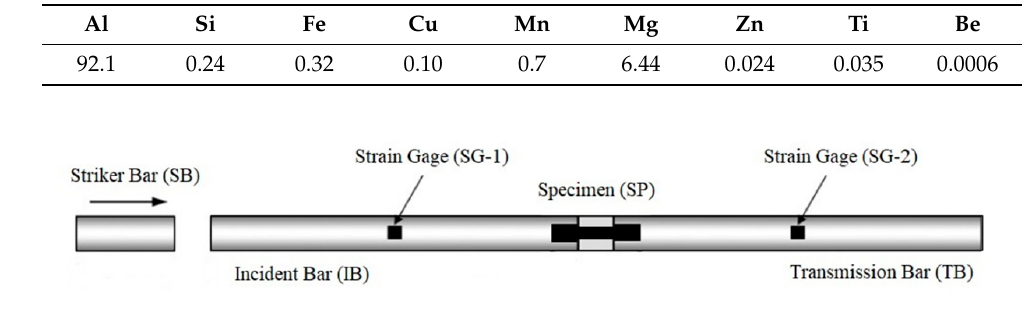
Figure 1. Split Hopkinson pressure bar apparatus.